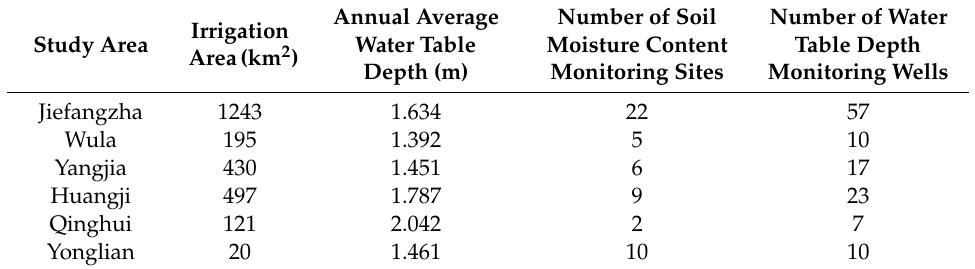
Table 1. The number of ground water and soil moisture content observation sites in each study area. Number of Water Number of Soil Annual Average Irrigation Table Depth Moisture Content Water Table Study Area Area(km 2 ) Monitoring Wells Monitoring Sites Depth (m) Jiefangzha 1243 1.634 22 57 Wula 195 1.392 5 10 Yangjia 430 1.451 6 17 Huangji 497 1.787 9 23 Qinghui 121 2.042 7 Yonglian 20 1.461 10